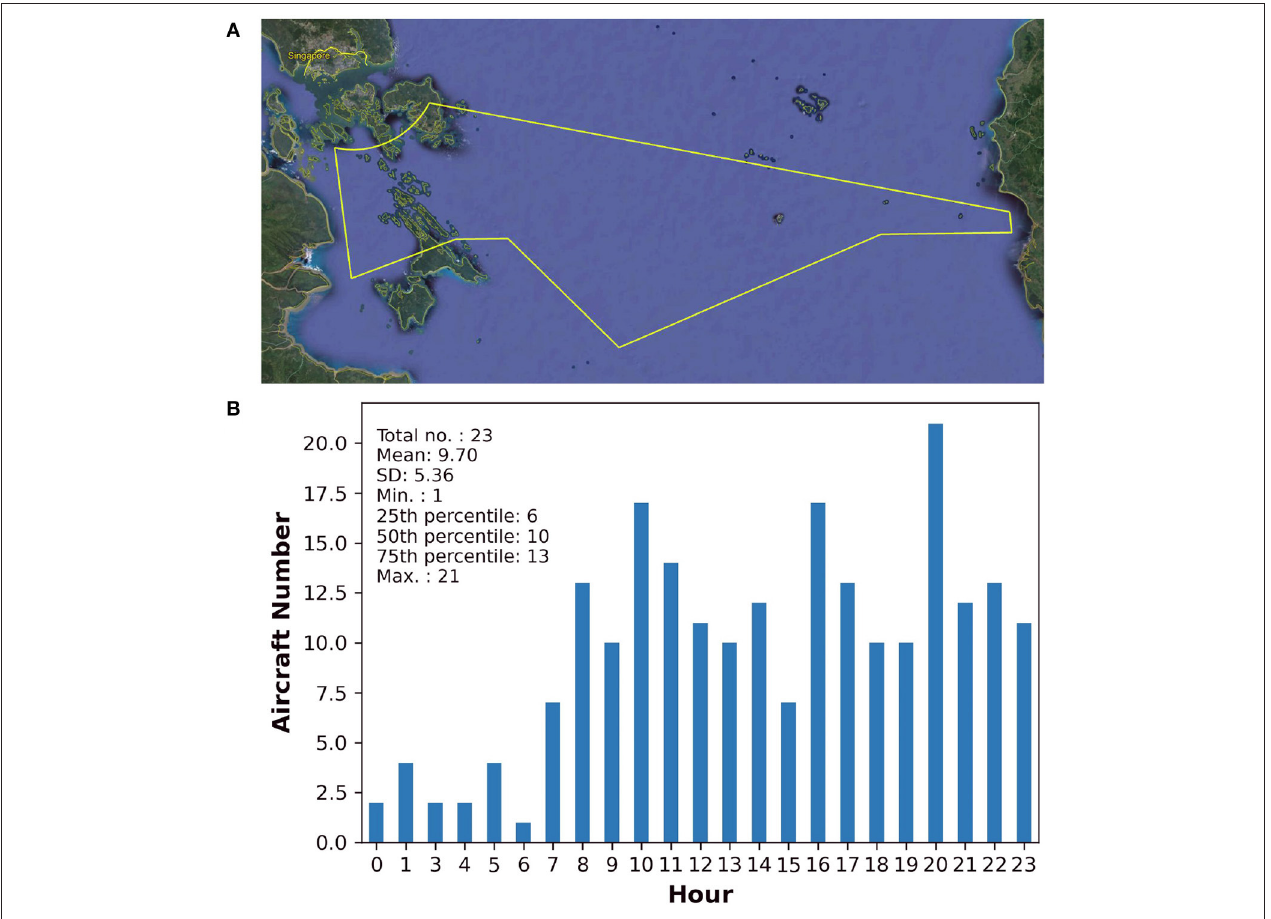
FIGURE 6 | Figure showing (A) the boundaries of an air traffic control (ATC) sector (colored in yellow) covering the airspace in the southeastern region of Singapore island generated using Google Earth and (B) the aircraft number recorded on a randomly selected 24-h working day in 2019 before COVID-19 outbreak. Descriptive statistics are shown on the top left corner; SD, Standard Deviation; Min., Minimum; Max.,